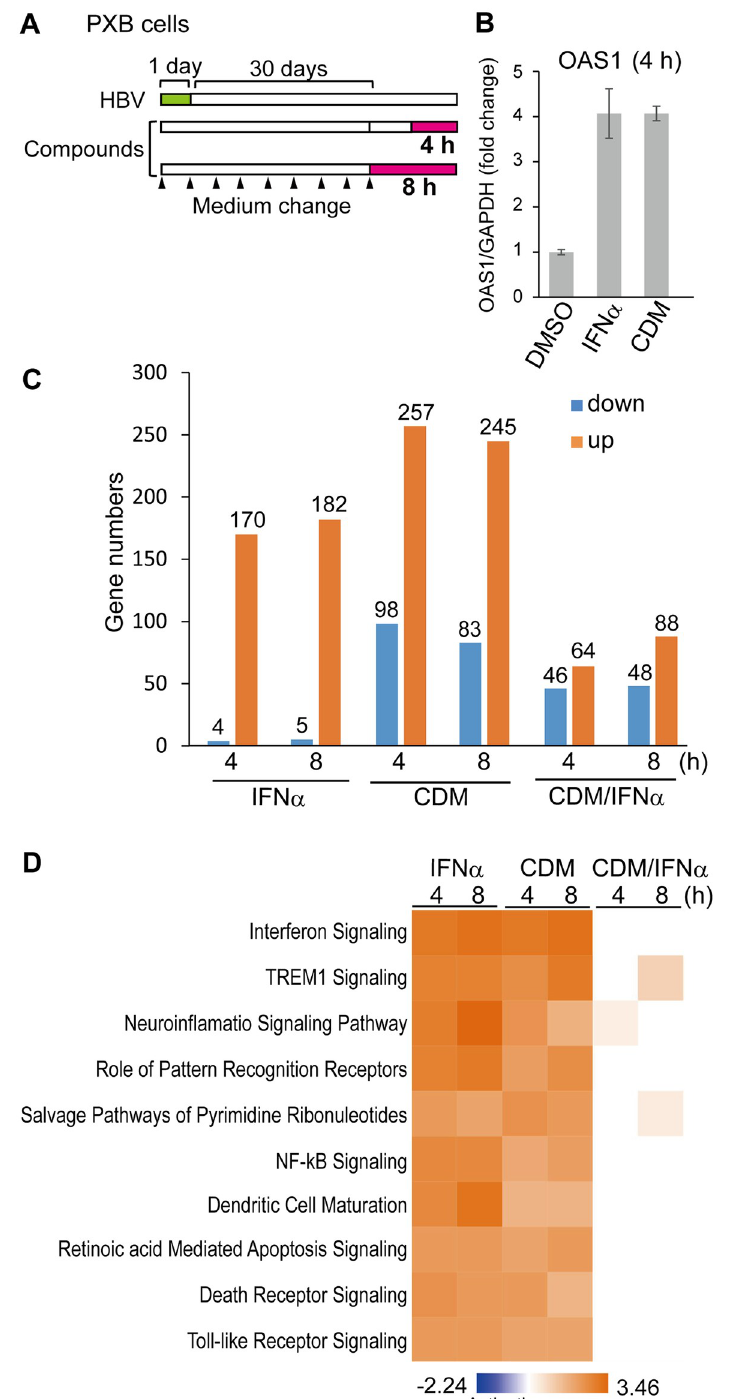
Fig 4. Microarray analysis of mRNA expression after CDM-3008 treatment. (A) Schematic of the experimental design of HBV infection and IFN α and CDM-3008 treatment prior to microarray analysis. PXB cells were infected with HBV genotype C for 1 day (green) and cultured for 30 days. The cells were then treated with 10 ng/ml IFN α or 30 μ M CDM-3008 for 4 h or 8 h (magenta). The black triangles show the times at which the medium was changed. (B) Analysis of OAS1 mRNA expression after 4 h of CDM-3008 or IFN α treatment. After 4 h of treatments with 10 ng/ml IFN α or 30 μ M CDM-3008, similar levels of OAS1 mRNA were induced. The error bars indicate S.D. (n = 3). (C)